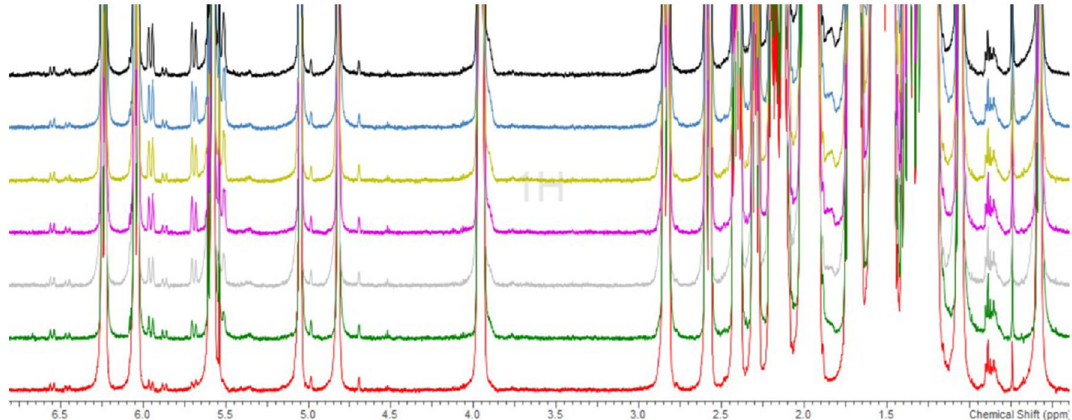
Figure 3. Overlay of 7 measurements at interval of 8 h, for 24( R ),25-dihydroxyvitamin D2 (2), highlighting the nature of impurities.